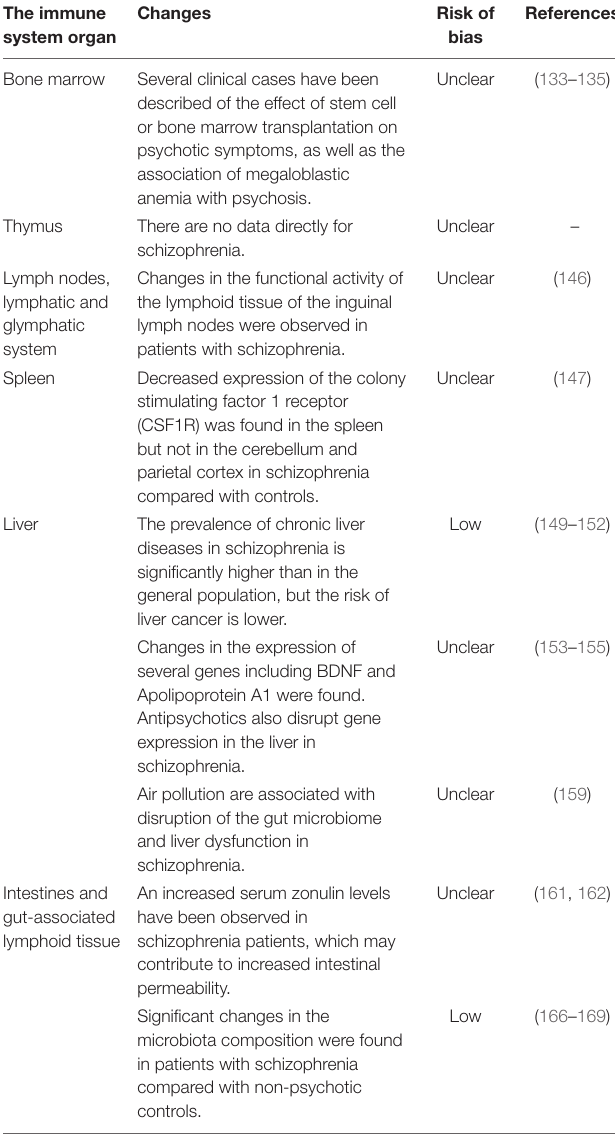
TABLE 6 | The immune system organs anomalies associated with